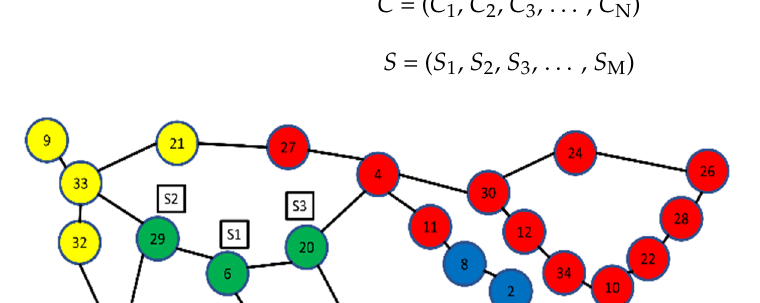
Figure 3. The controller placement effect on the QoS.